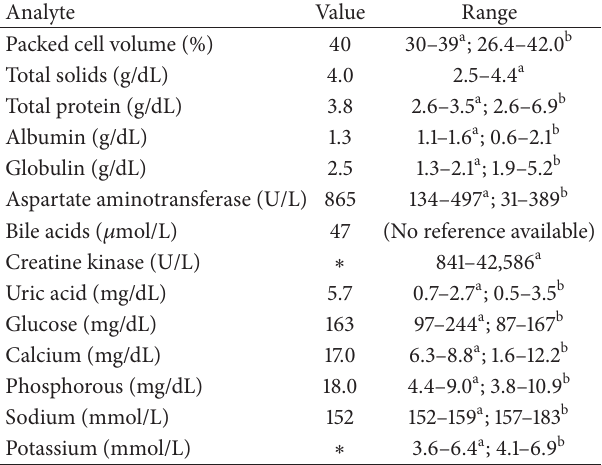
Table 2: Plasma chemistry and hematology results from a large mesh gillnet entangled green sea turtle ( Chelonia mydas ). PCV/TS was performed at initial presentation. Plasma chemistry performed using the VetScan Avian Reptilian Profile Plus reagent rotor at 4 hours after presentation. Range values based on published free- ranging juvenile green sea turtles from North Carolina caught via pound nets [18] and from the Bahamas during diving [20].